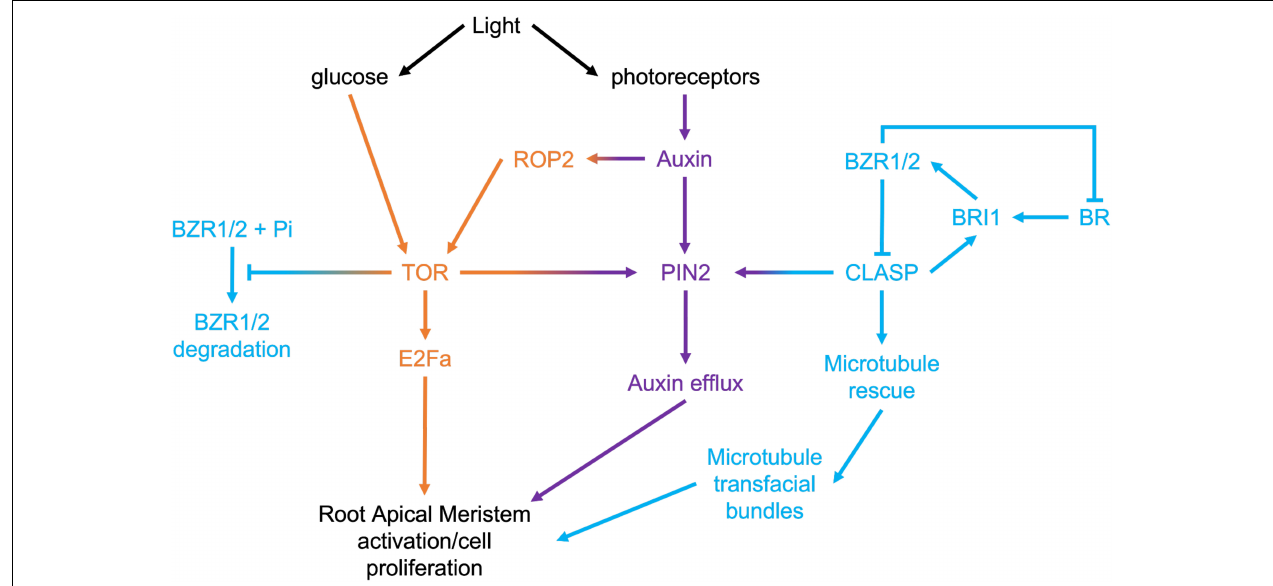
FIGURE 3 | Signaling pathways that converge in the regulation of root apical meristem growth.